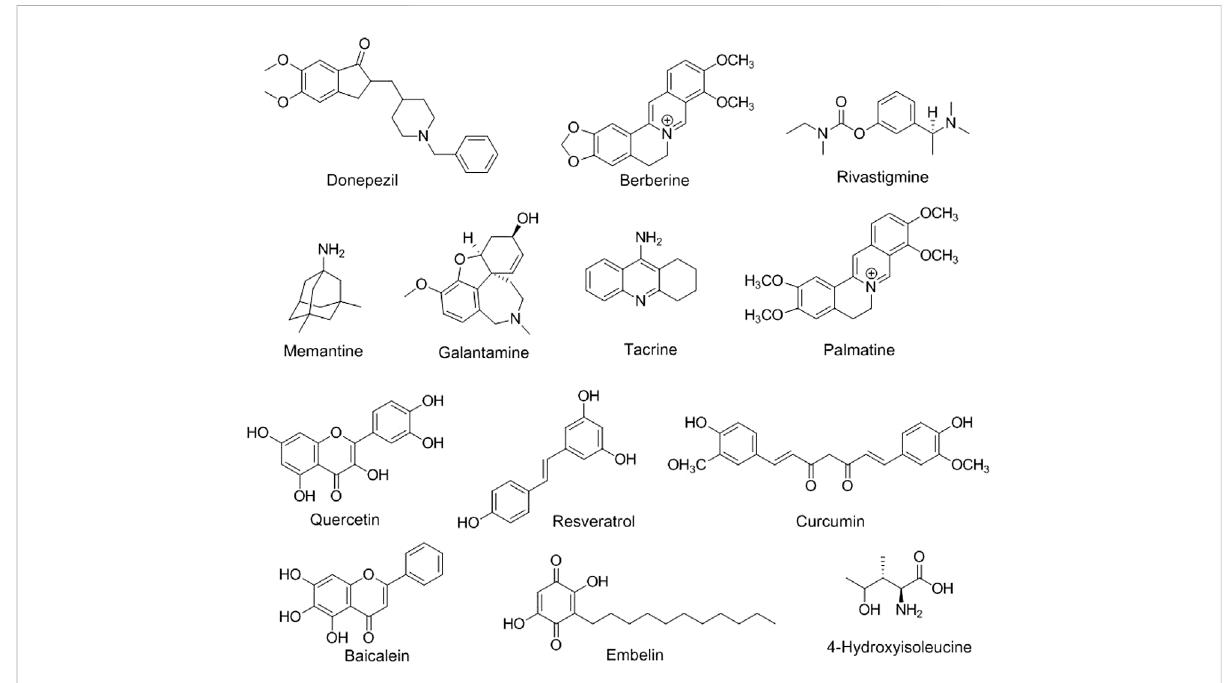
FIGURE 2 Chemical structures of different phytoconstituents in neurological